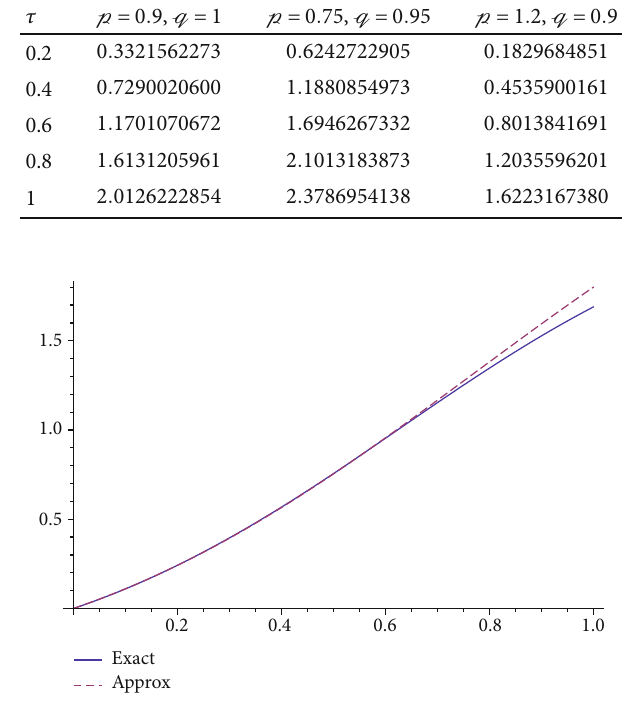
Figure 1: A comparison of the exact solution and three terms ’ approximate solution when p = 1, q = 1